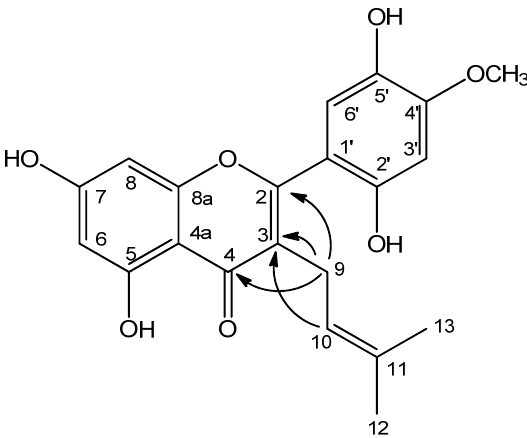
Figure 4. HMBC correlations (from H to C) of compound 3 .